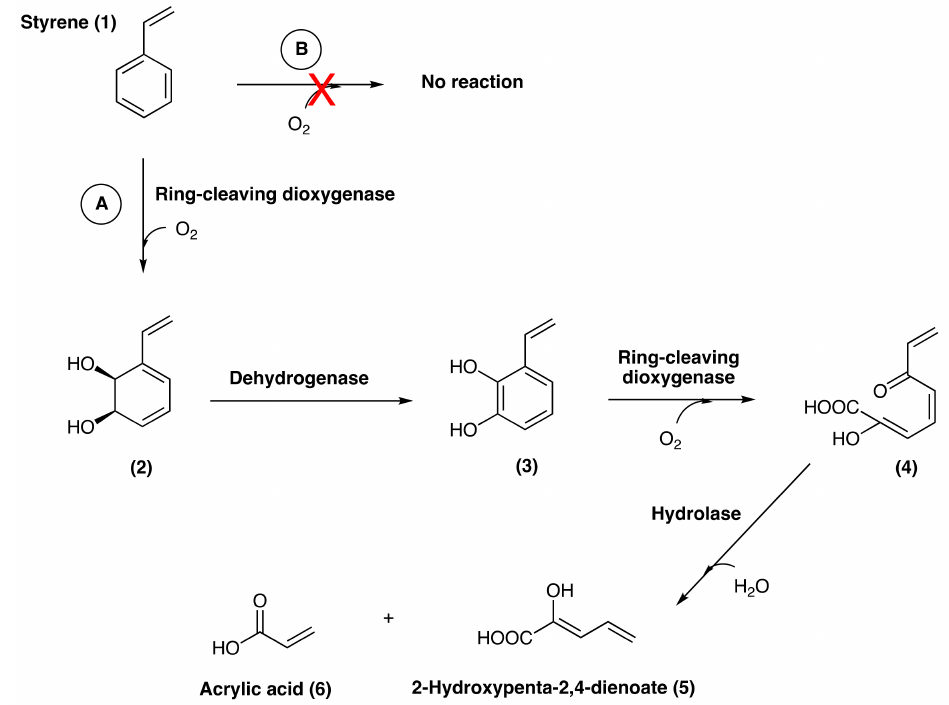
Figure 8. Proposed oxygen-dependent pathway of PS degradation based on the experimental data via activities of an orphan aromatic ring-cleaving dioxygenase and hydrolase enzymes [ A ]. No degradation occurs under oxygen-limited conditions [ B